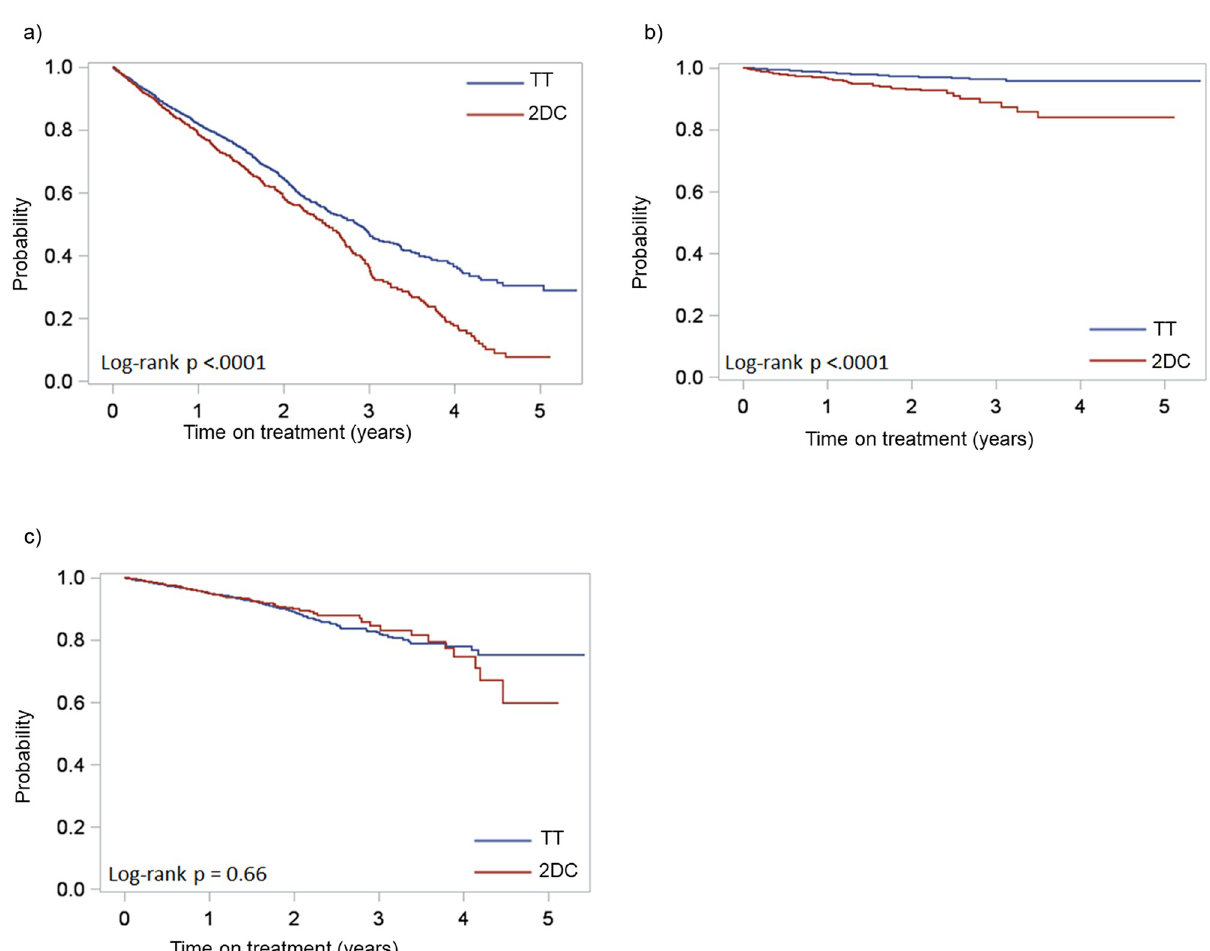
Fig 1. Kaplan-Meier curve for two-drug combinations versus triple therapy: a) time to discontinuation), b) switch due to virologic failure, c) switch due to toxicity. TT: triple therapy; 2DC: two-drug combination.